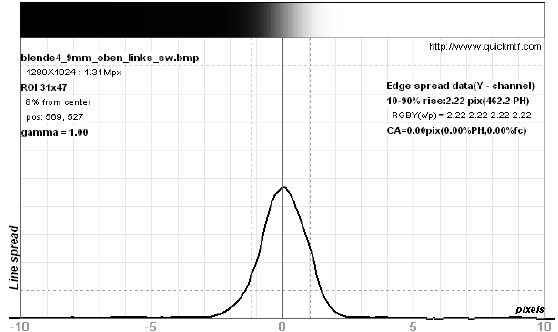
Figure 12: Line Spread Function (LSF) at image